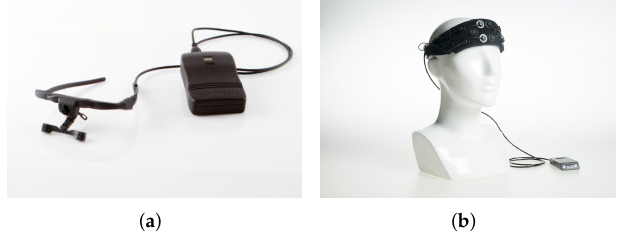
Figure 3. Devices. ( a ) Dikablis Glasses 3, ( b ) Artinis